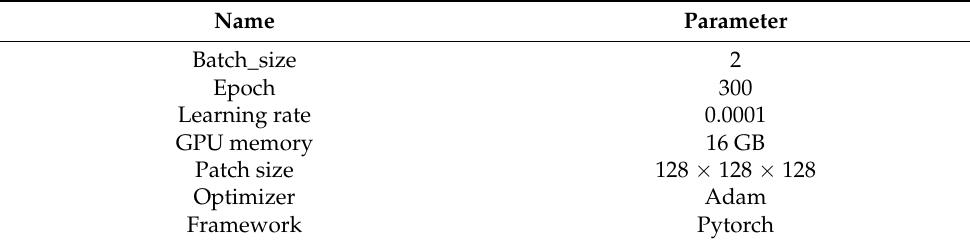
Table 2. The training parameter of the proposed